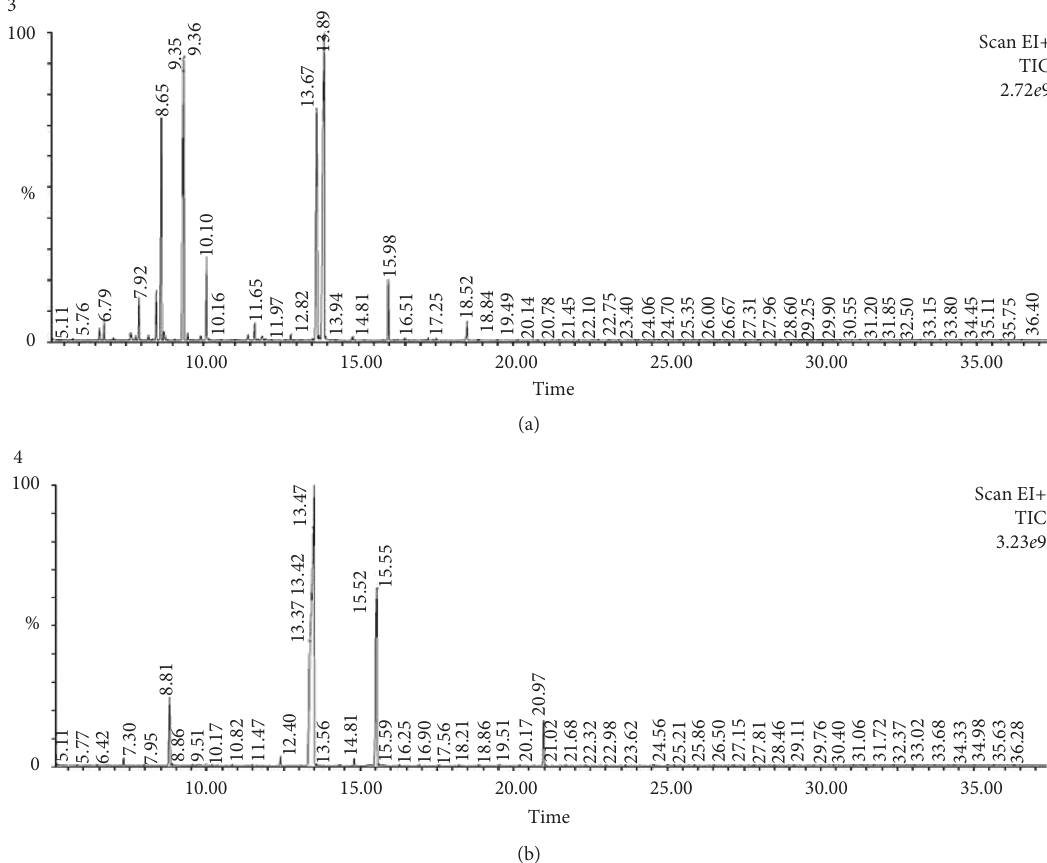
Figure 2: Qualitative report of the essential oil of (a) oregano and (b)